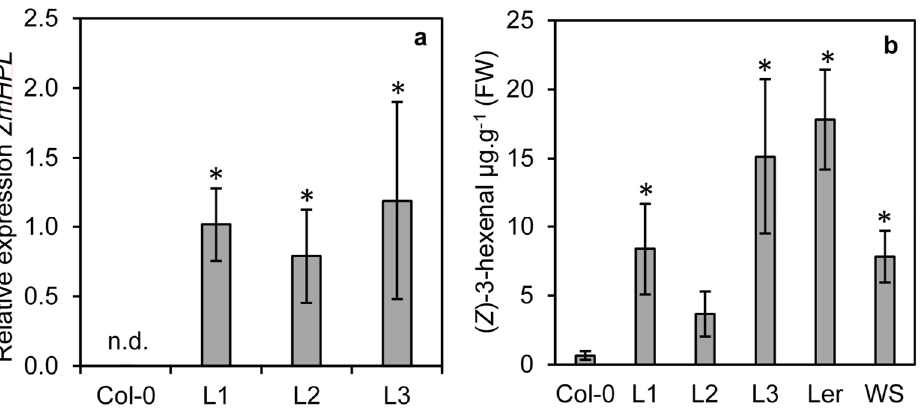
Figure 3. Expression of ZmHPL in HPL deficient Arabidopsis ecotype Col-0 restores ( Z )-3-hexenal production. The Col-0 ecotype of Arabidopsis (a natural loss-of-function mutant in AtHPL ) was agrotransformed to constitutively express ZmHPL . Three lines from independent transformation events L1, L2 and L3 were assessed for their expression of ZmHPL using qRT-PCR, n.d. = not detected ( a ). Production of ( Z )-3-hexenal was measured from Col-0, the three transgenic lines and two Arabidopsis ecotypes that have wild-type AtHPL activity (Ler and WS) ( b ). Bars show the average of n = 4 samples per line, ± S.E.M. Asterisks indicate significantly different values from Col-0 at p ≤ 0.05 as determined by a t -test.